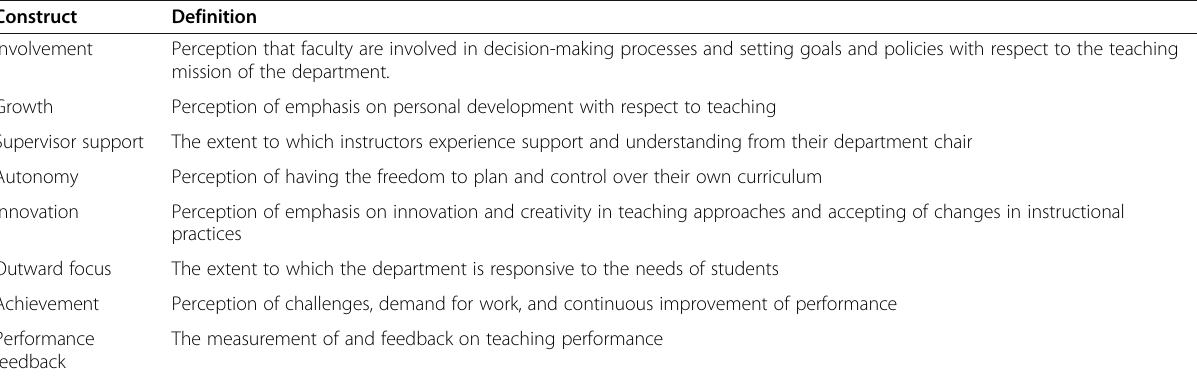
Table 2 Definitions of the constructs measured in the Departmental Climate around Teaching survey